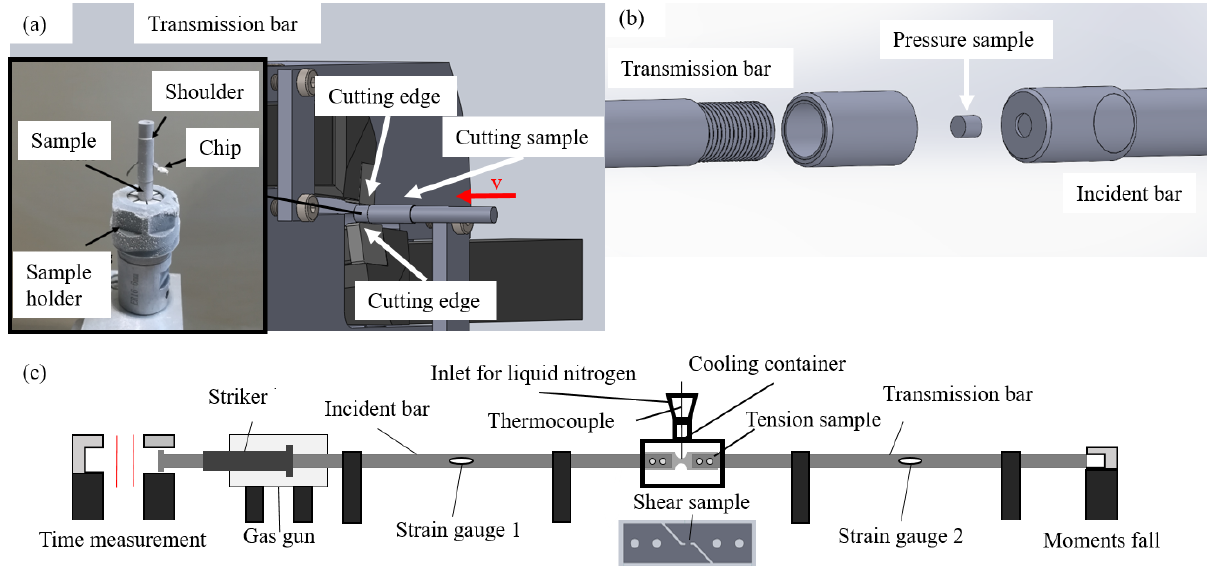
Figure 3. Clamped samples: ( a ) cutting experiment, ( b ) compressive test, ( c ) tensile/shear test.